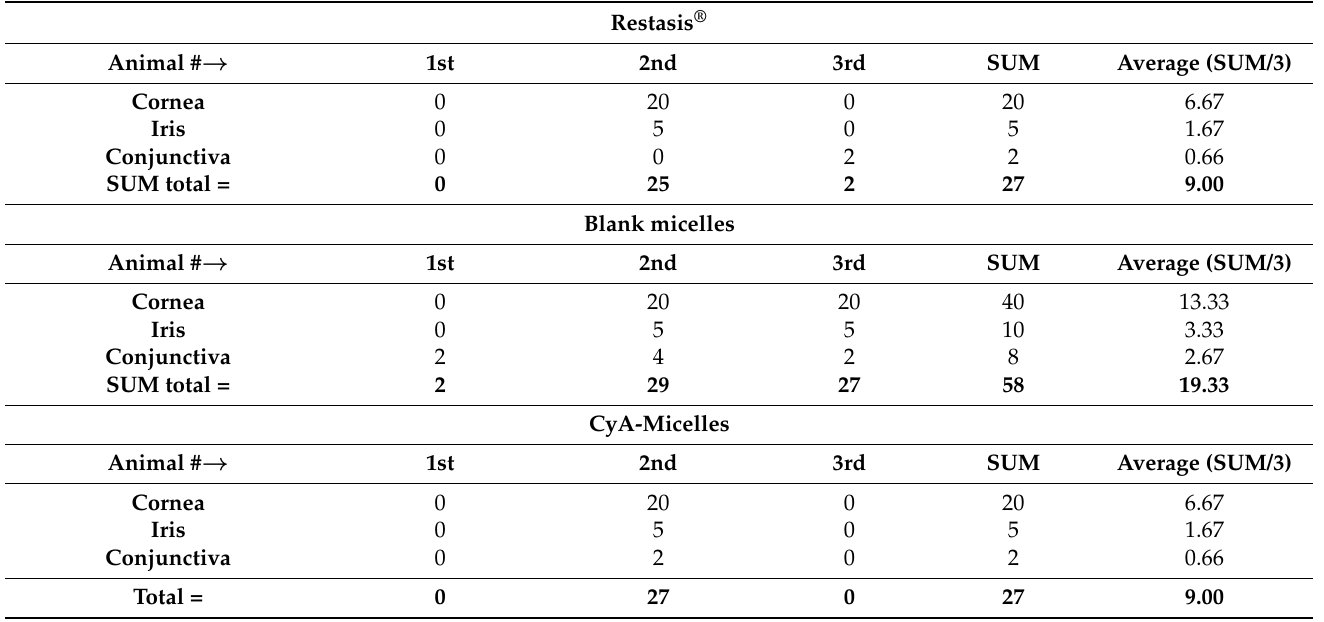
Figure 10. Photographs captured during irritation study in rabbit eyes. NaCl treated eyes of respective groups ( a , a (cid:48) , a (cid:48)(cid:48) ) (green arrows). Post instillation of blank Myrj S100- b -PCL 88 micelles at 1 h ( b ) (red arrow); at 3 h ( c ) (black arrow); at 6 h ( d ) and at 24 h ( e ). Post instillation of CyA-loaded Myrj S100- b -PCL 88 micelles (CyA-Micelles) at 1 h ( b (cid:48) ) (red arrow); at 3 h ( c (cid:48) ) (black arrow); at 6 h ( d (cid:48) ) and at 24 h ( e (cid:48) ). Post instillation of Restasis ® at 1 h ( b (cid:48)(cid:48) ); at 3 h ( c (cid:48)(cid:48) ); at 6 h ( d (cid:48)(cid:48) ) and at 24 h ( e (cid:48)(cid:48) ). All other images did not show any redness or abnormal discharge (i.e., indicating the normal features) were represented by green arrows. Table 5. Maximum Mean Total Score (MMTS) calculations for the tested formulations as per the obtained scores in Table